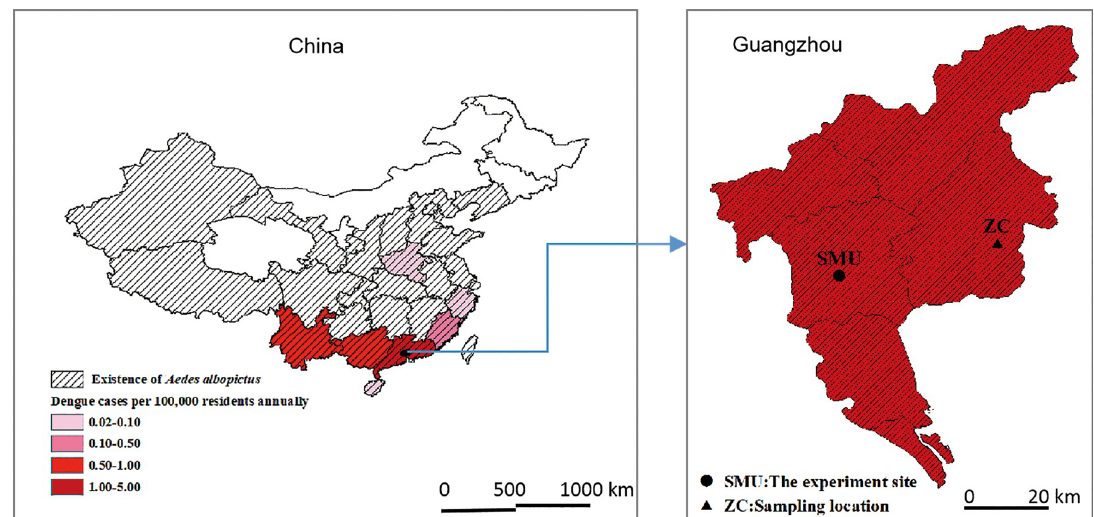
Fig 1. Distribution of Aedes albopictus (slash line), dengue incidence (by color palette) in China and the study sites. Polygon represents province on map of China and district on map of Guangzhou.